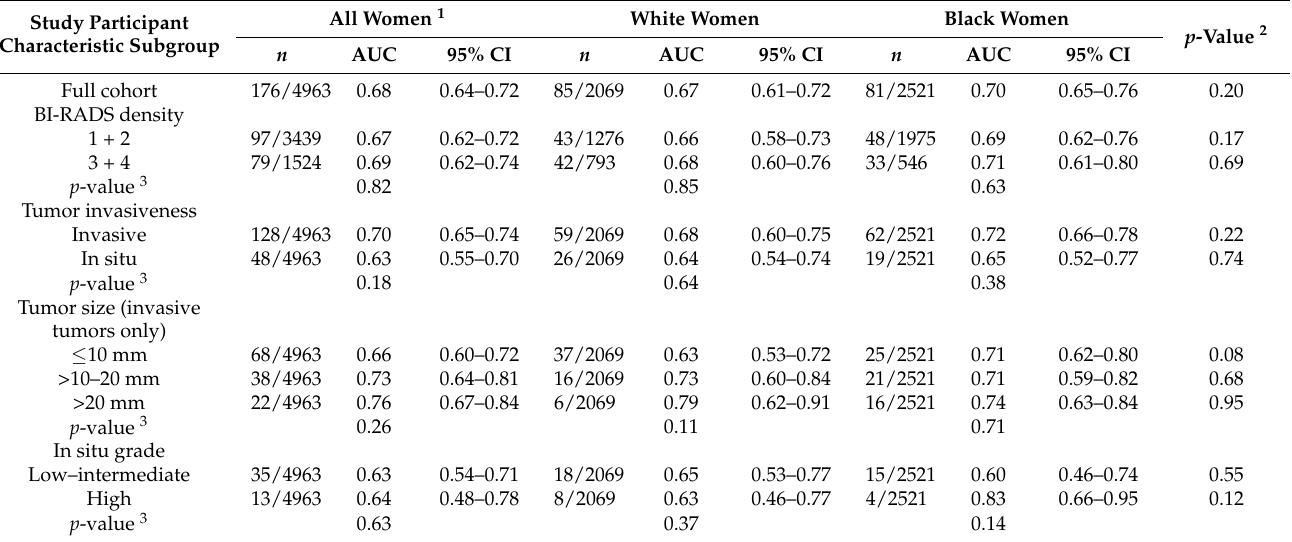
Table 3. Discriminatory performance (AUC) in the full cohort and in subgroups of women by mammographic density and tumor characteristics, stratified by White and Black